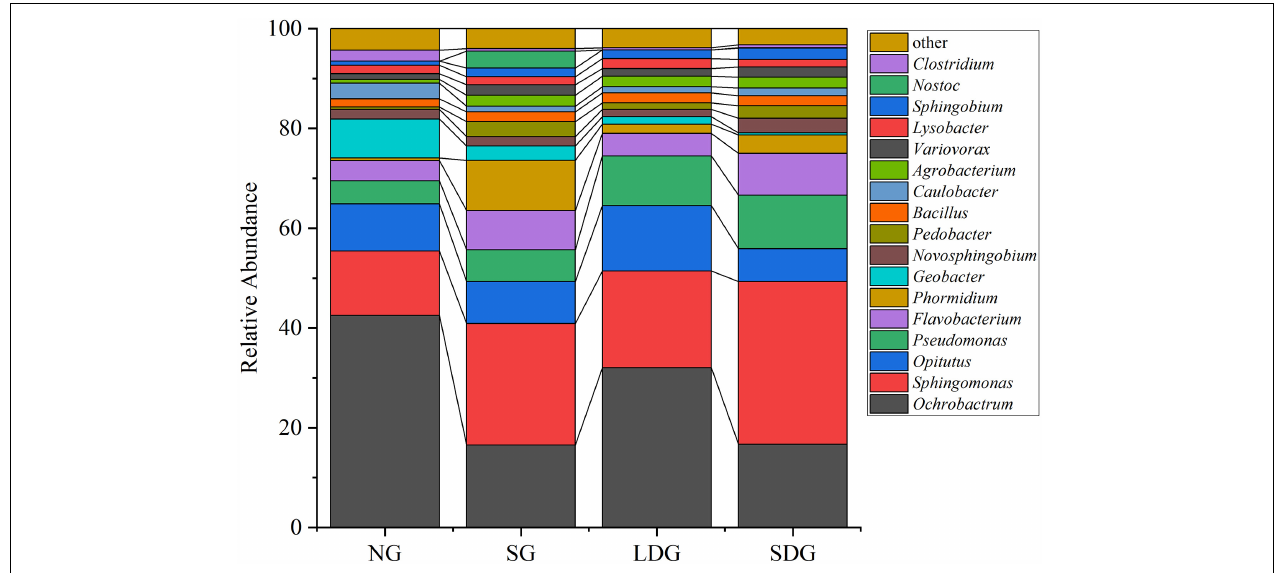
FIGURE 3 | Relative abundance of asymbiotic nitrogen-fixing bacteria at the genus level in different grassland types. Each color represents the corresponding genus. NG, natural grassland; SG, sown grassland; LDG, lightly degraded grassland; SDG, severely degraded grassland.